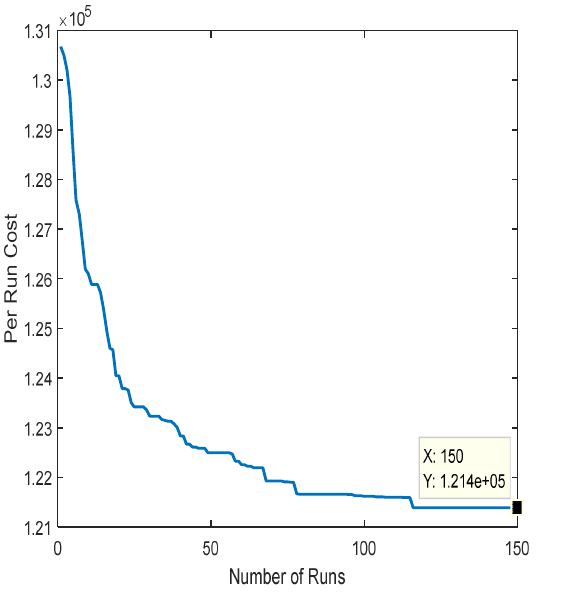
FIG. 8: CONVERGENCE CHARACTERISTIC OF 40 UNIT TEST SYSTEM (P 3 = 10500MW